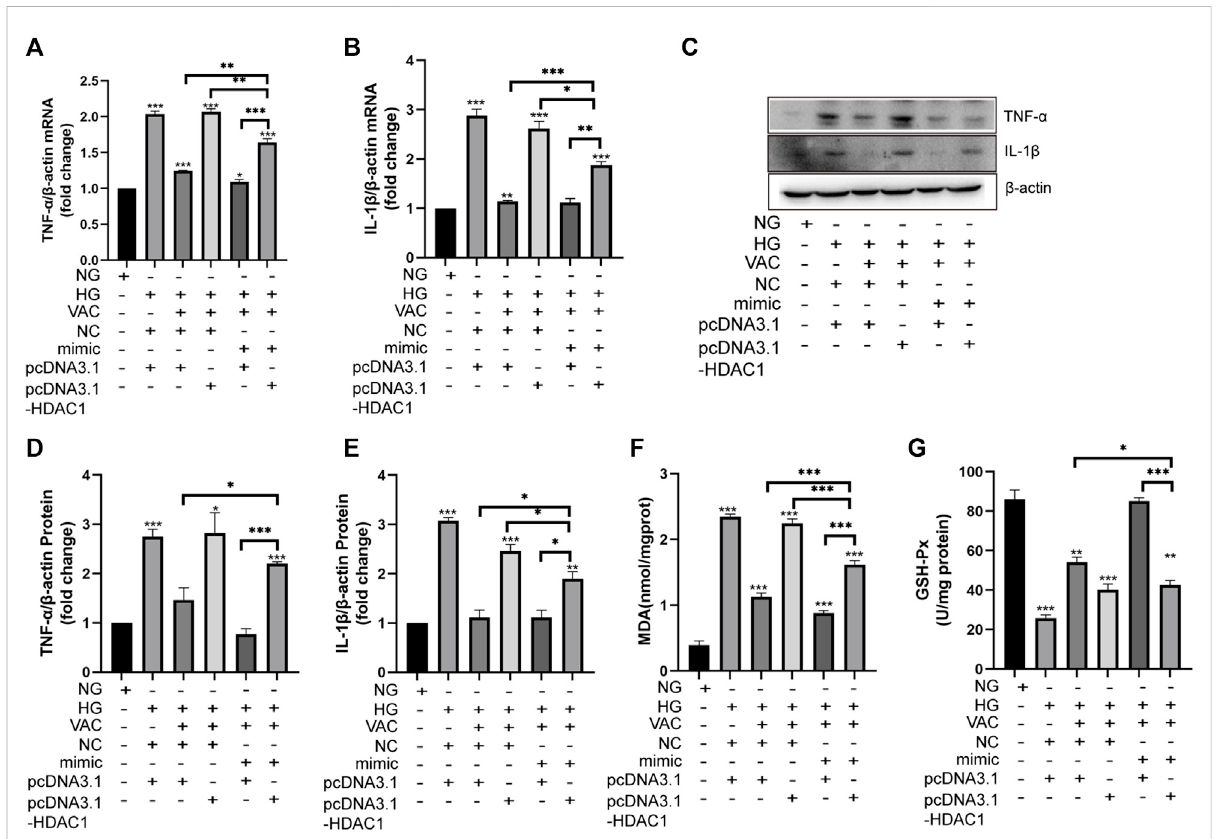
Effectofvaccarinonthein fl ammatoryinjurywhenco-transfectedwithmiR-570-3pmimicandpcDNA3.1-HDAC1. (A,B) .Theeffectsofvaccarin on the expression of TNF- α mRNA and IL-1 β mRNA in HUVEC cells transfected with miR-570-3p NC or miR-570-3p mimics or pcDNA3.1 or pcDNA3.1-HDAC1. (C,E) . Western blotting analysis of TNF- α and IL-1 β protein expression levels in HUVEC cells transfected with miR-570-3p NC or miR-570-3p mimics or pcDNA3.1 or pcDNA3.1-HDAC1. Gray value of western blotting. (F) . Content of MDA. (G) . Activity of GSH-Px. Values